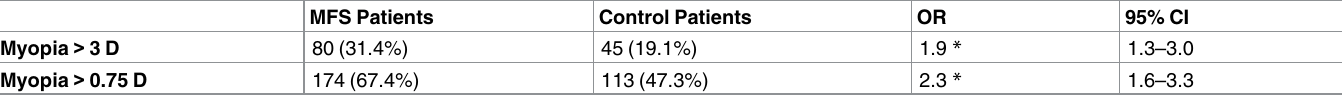
Table 2. Frequencies and odds ratio for different degrees of myopia as a diagnostic criterion for Marfan syndrome. Odds ratios (OR) are adjusted for genderand age. 95% CI = 95% confidenceinterval. If only one eye of a patient fulfilled the criterion, the patient was includedin the respectivecategory. Aphakic, pseudophakic and eyes with a history of retinal detachmentrepair were excluded.(D =